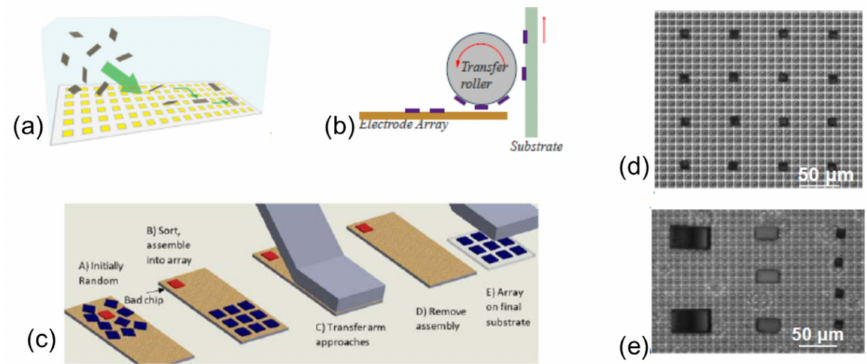
Figure 28. Schematic view of the microassembly system based on electrostatic field, where micro- objects ( a ) initially in solution are manipulated with electrode arrays (yellow) and then ( b ) transferred to a final substrate with a roller or continuous belt process. ( c ) Flat contact stamp transfer. ( d ) Chiplets assembled in an array and ( e ) heterogenous chiplet assembly of chips of different sizes. Adapted with permission from [289]. Copyright IEEE,